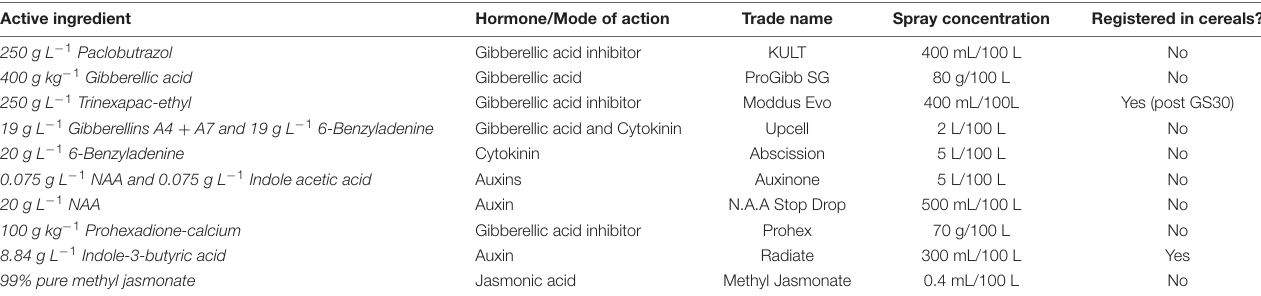
TABLE 1 | Summary of the different plant hormones and PGR products used in Experiment 1 with their respective active ingredient and concentration. Active ingredient